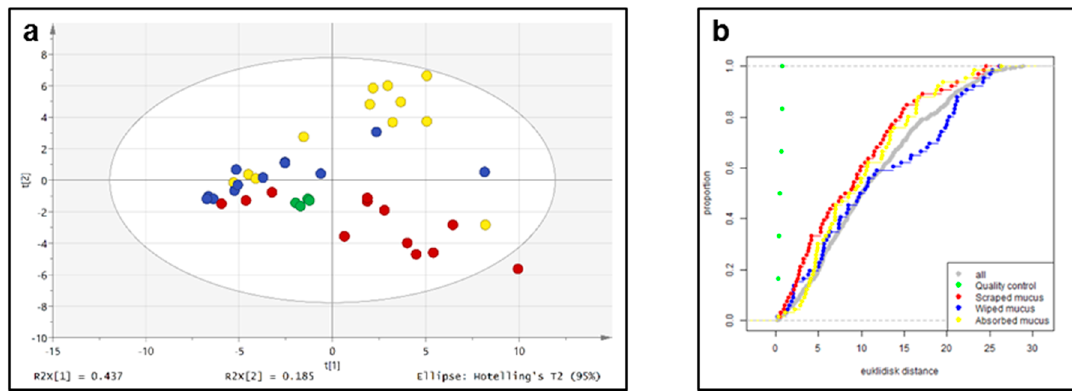
Figure 3. Score plot from principal component analysis (PCA) ( a , unit variance scaled) of the metabolite profiles obtained from targeted LC–HRMS (including 49 metabolites) and corresponding cumulative Euclidic distance plot of the same data ( b ); quality control samples in green, scraped mucus samples in red, wiped mucus samples in blue, and absorbed mucus samples in yellow. The two first principal components explain 62% of the total variation.